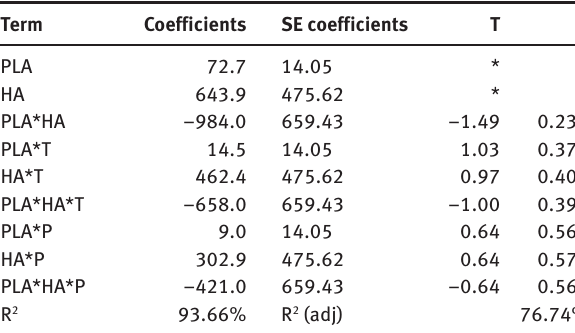
Table 7: Coefficient analysis of tensile